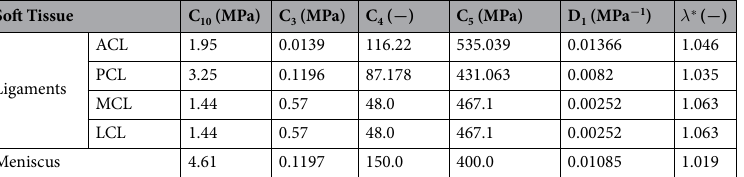
Table 1. Material constants for the ligaments (ACL: Anterior Cruciate Ligament; PCL: Posterior Cruciate Ligament; MCL: Medial Collateral Ligament; LCL: Lateral Collateral Ligament) and the intact meniscus 24, 29